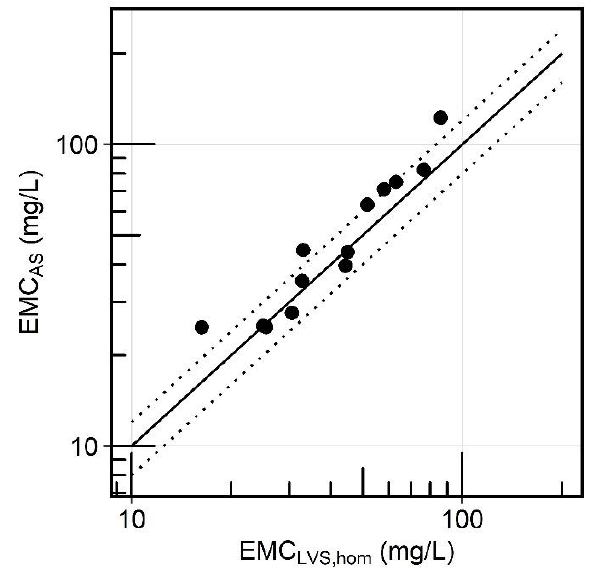
Figure 6. Scatterplot of TSS event mean concentrations derived from homogenized large-volume samplers samples (EMC LVS,hom ) and autosamplers pollutographs (EMC AS ). Dotted lines show 20% deviation.